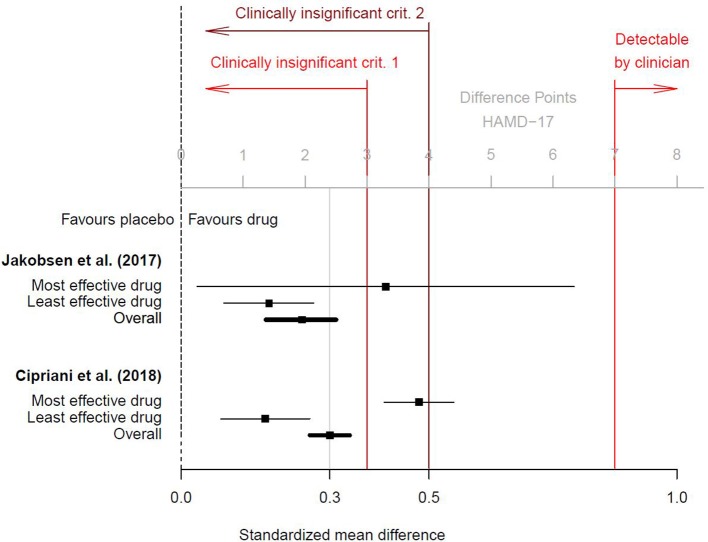
Clinical significance of antidepressants, based on the results of Cipriani et al. (1); additional online information (p. 150) and of Jakobsen et al. (14). Black squares are the standardized mean differences d (drug vs. placebo) for the most and least effective drug and for the overall effect. Horizontal lines are the related 95% confidence intervals. Two conventions for clinical insignificance were used. Criterion 1 was a difference of <3 points on the HAMD-17 scale (corresponding to d < 0.4), and criterion 2 was d < 0.5. Only differences of at least 7 points on the HAMD-17 scale were found to be detectable by clinicians (16). To transform standardized mean differences into mean point-differences on the HAMD-17 (or vice versa), we assumed a pooled standard deviation of SD = 8.0, as suggested by Moncrieff and Kirsch (16) and which conforms to data provided in the online appendix by Cipriani et al. (1).